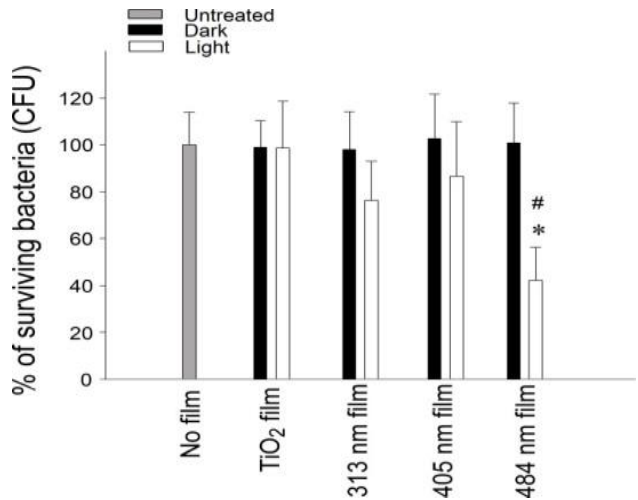
Figure 5. Visible-light - induced photolytic killing of Escherichia coli with or without treatments on various TiO 2 substrates. Pure TiO 2 films as well as 313, 405, and 484 nm TiO 2 (B) thin films were used. The percentage of surviving bacteria without placement on the films (no film, untreated groups) was normalized to 100%. n = 6, # p < 0.05 (compared with the respective untreated group); * p < 0.05 (compared with the respective dark group).